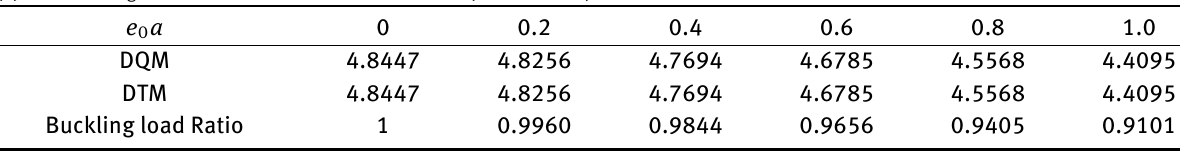
Table 5: Buckling load ratio for various scale coeflcient (a)